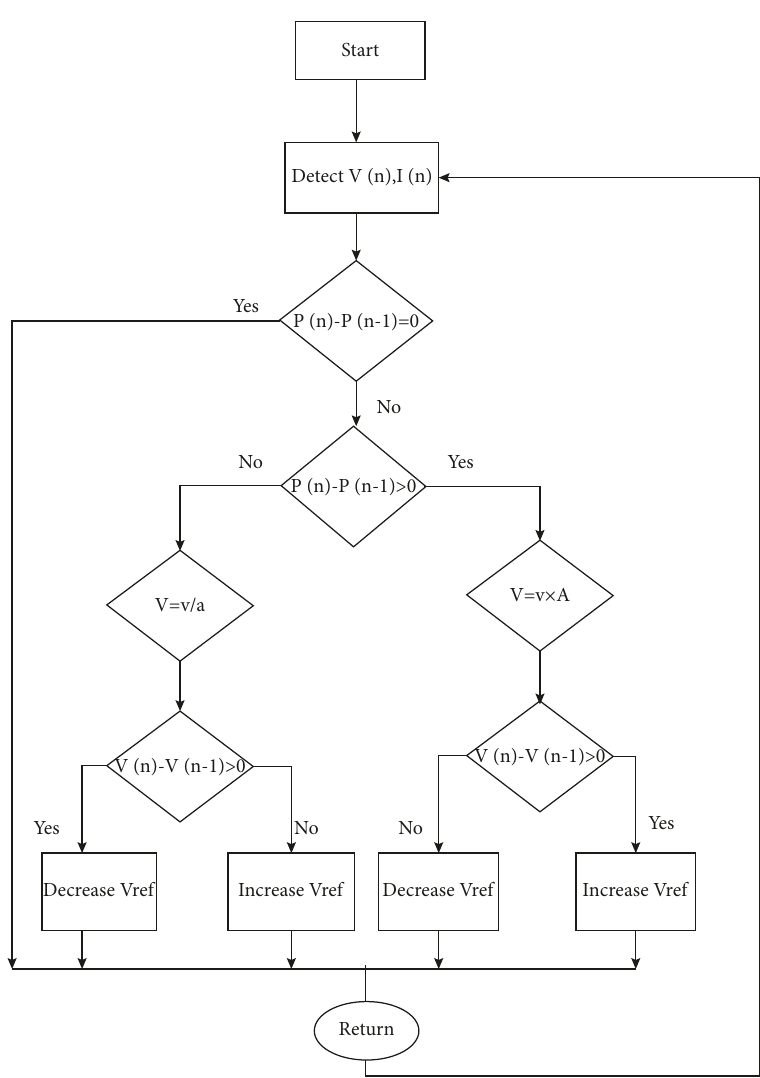
Figure 5: Modified perturb and observe